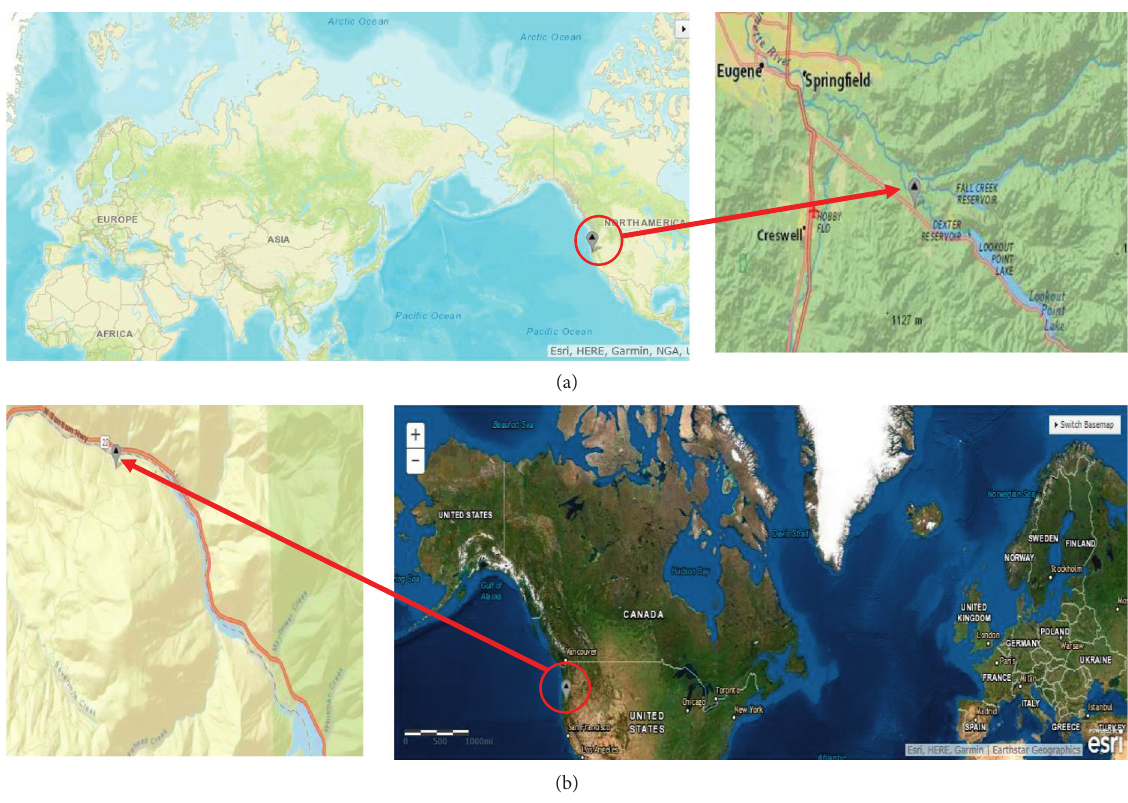
Figure 1: The location site of case studies. (a) USGS 14150000. (b) USGS 14181500.